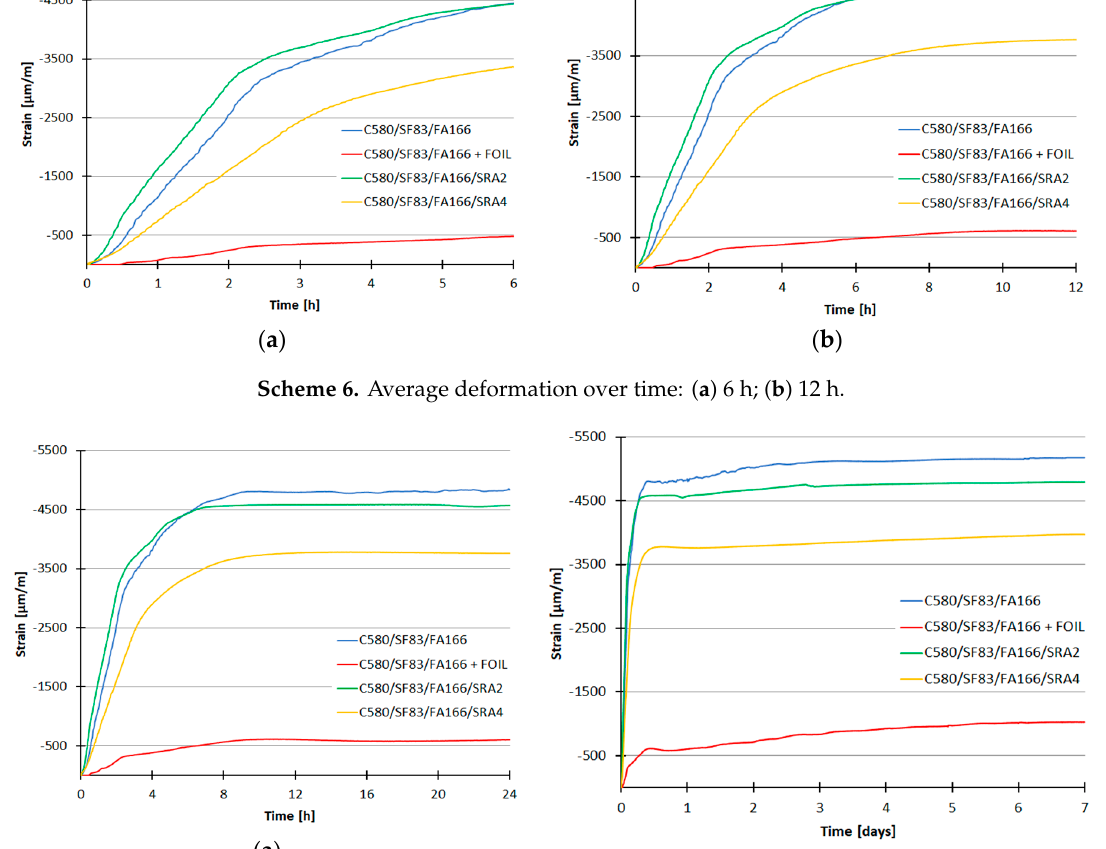
Scheme 6. Average deformation over time: ( a ) 6 h; ( b ) 12 h.